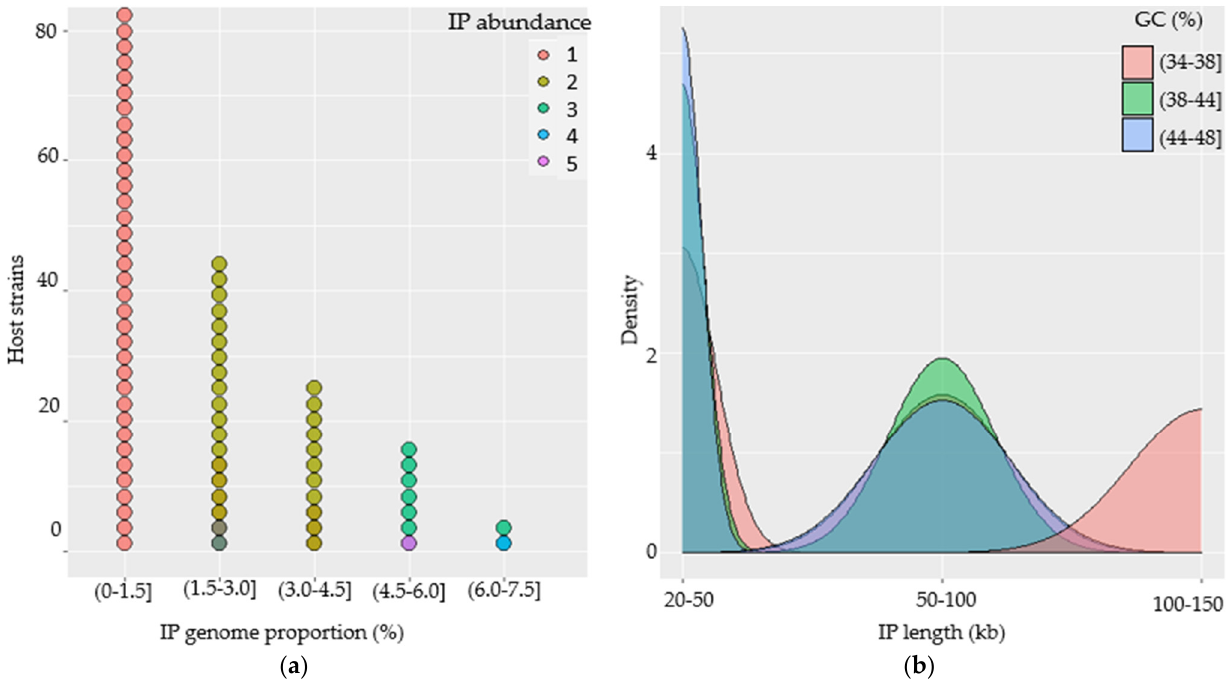
Figure 3. Characterization of intact prophages (IPs) in the genomes of B. subtilis strains. ( a ) Dotplot illustrating IP abundance and genome proportion per genome of their host and their associations. ( b ) Density plot showing the distribution and association of IPs in terms of their genome size and GC-content.